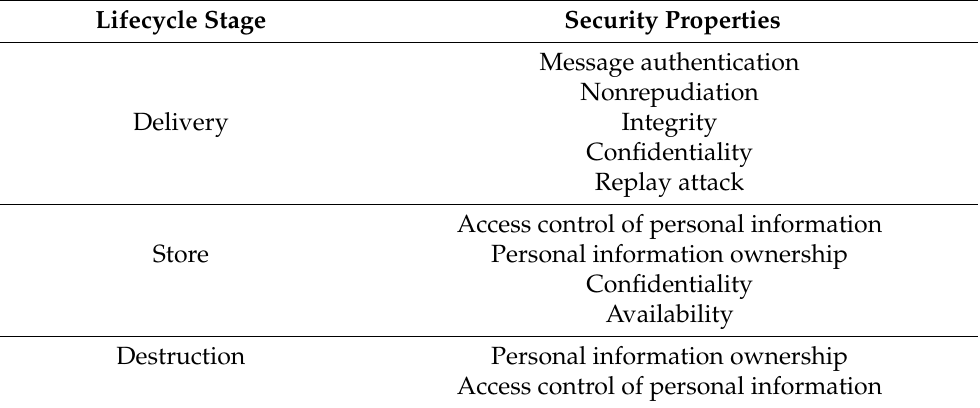
Table 4. Security properties required in the lifecycle stages of personal